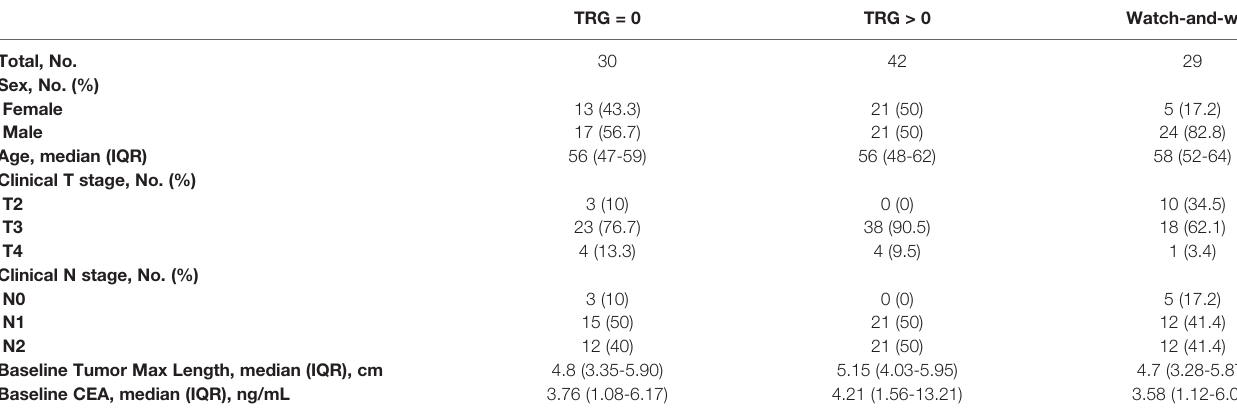
TRG = 0 TRG > 0 Watch-and-wait